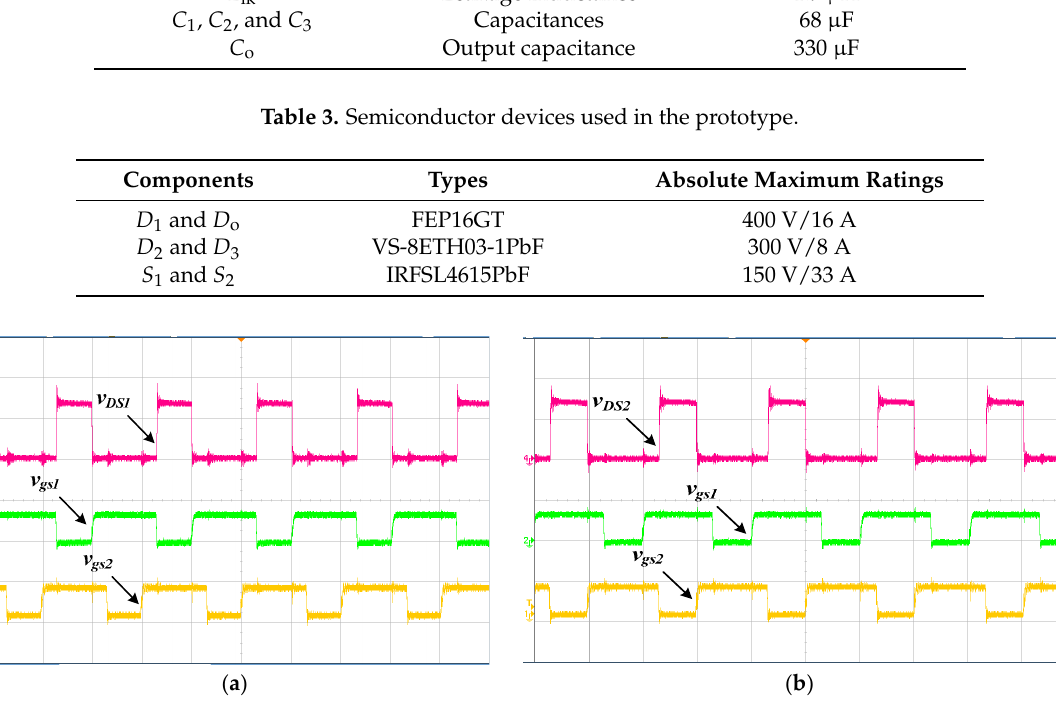
Figure 4. Experimental waveforms of active power switches in CCM operation and at D = 0.62. ( a ) v DS1 and the corresponding control signals ( v DS1 : 50 V/div, v gs1 and v gs2 : 10 V/div, time: 10 μ s/div). ( b ) v DS2 and the corresponding control signals ( v DS2 : 50 V/div, v gs1 and v gs2 : 10 V/div, time: 10 μ s/div).